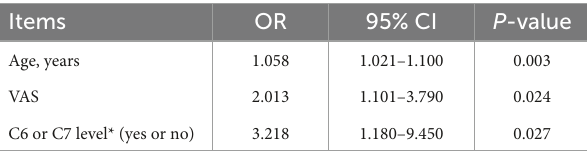
TABLE 2 Multivariable logistic regression analysis of limb weakness in HZ